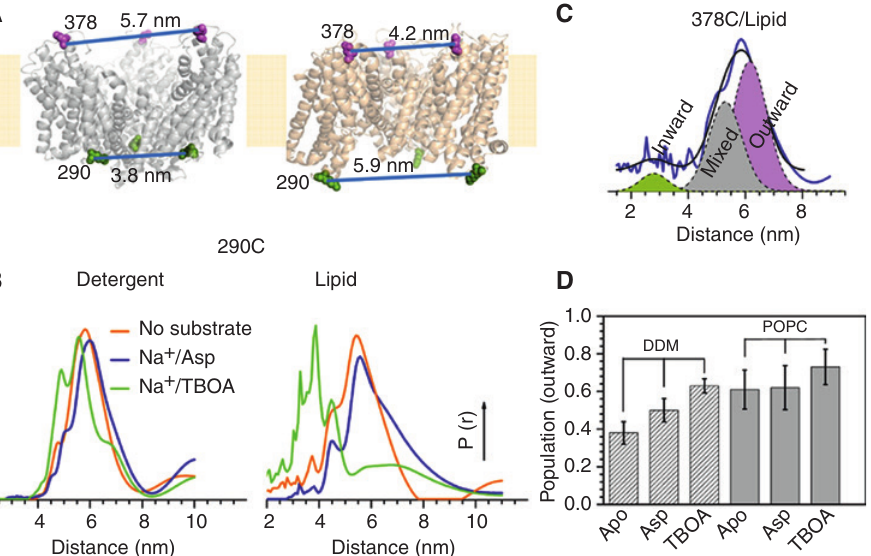
Figure 9: In detergent solution and in lipid membranes GltPh protomers occupy outward and inward facing conformations with almost equal probability (Ref. 57). (A) Glt homotrimer in outward (PDB 2NWX) and inward (PDB 3KBC) facing states is shown. Indicated are the Ph position of residue 290 (green) and 378 (magenta) used for spin-labeling and expected C -C distances based on crystal structures. (B) β β DEER-derived distances for spin-labeled residue 290C in detergent (left) and in POPC lipid (right) are shown. Broad distance distributions covering distances expected for both outward and inward facing state were obtained. (C) Experimental distance distributions were fitted to a sum of three Gaussians whose weights are defined by the probability of a protomer to occupy outward, inward, or mixed (inward and -outward) state; thus the populations of the two global conformations (i.e. these open to periplasm or cytoplasm) were determined – as demonstrated for the residue 378C in the case of lipid. (D) Based on these analyses, it was established that Glt protomers sample Ph outward and inward facing conformations with almost equal probability regardless of the presence of substrate (Na + /Asp) or inhibitor (Na +